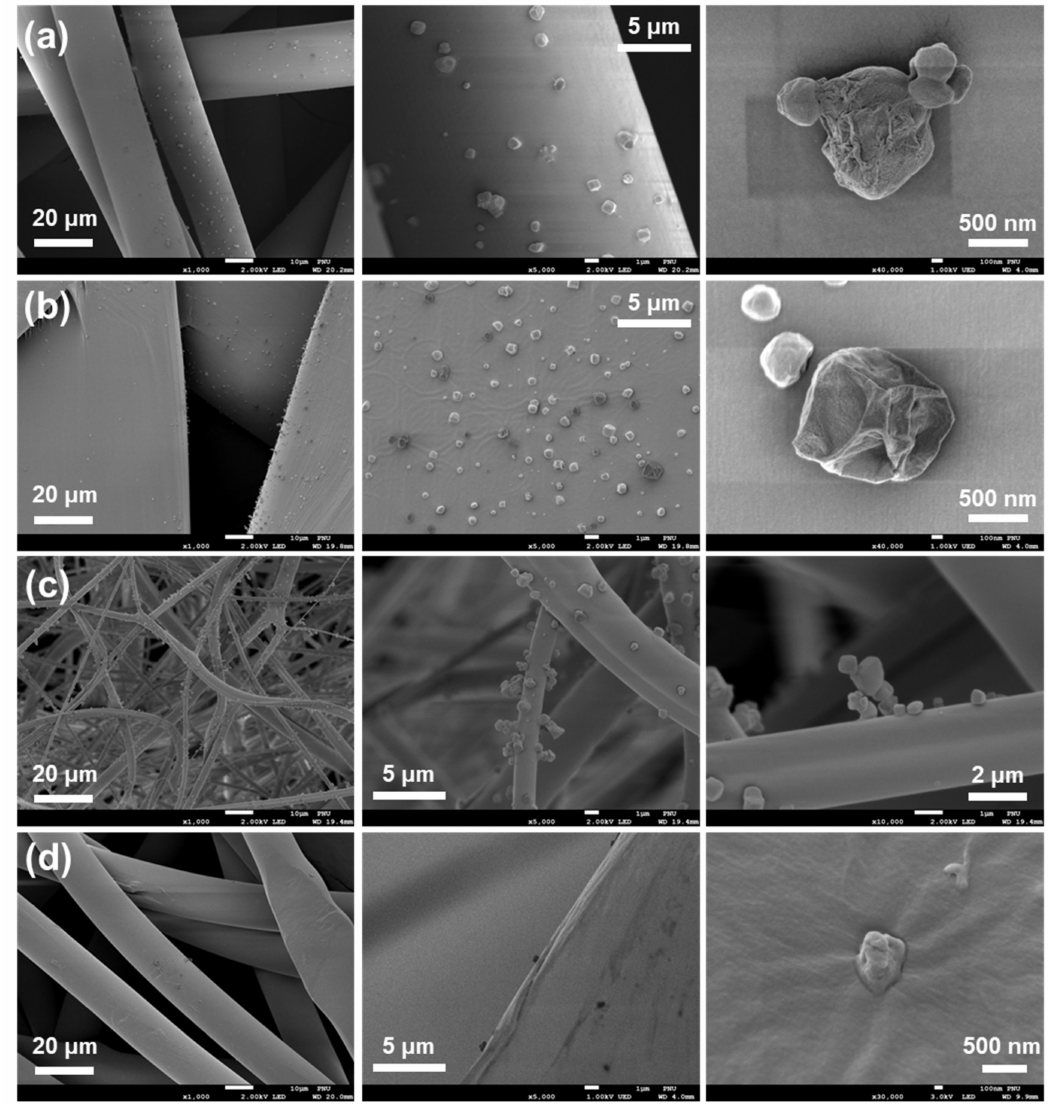
Figure 5. Scanning electron microscopy (SEM) images of a KF94 mask after it was used to filter airborne droplets containing bacteria. ( a ) Outer, ( b ) support, ( c ) filter, and ( d ) inner